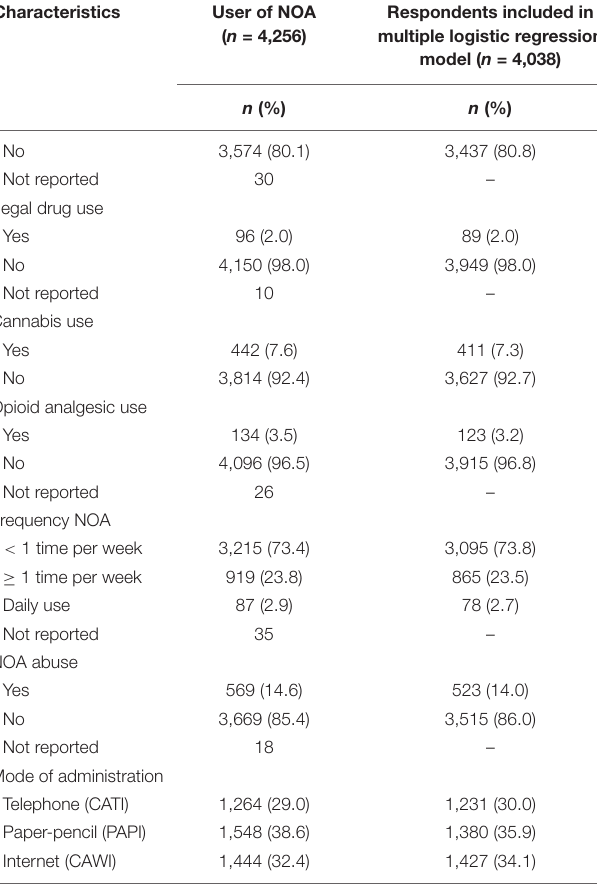
TABLE 1 | Sociodemographic, behavioral- and health-related characteristics of individuals using NOA and individuals included in multiple logistic regression